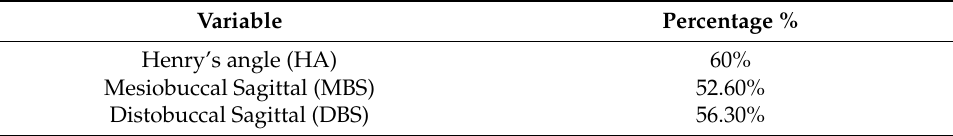
Table 3. Predictability of the changes: